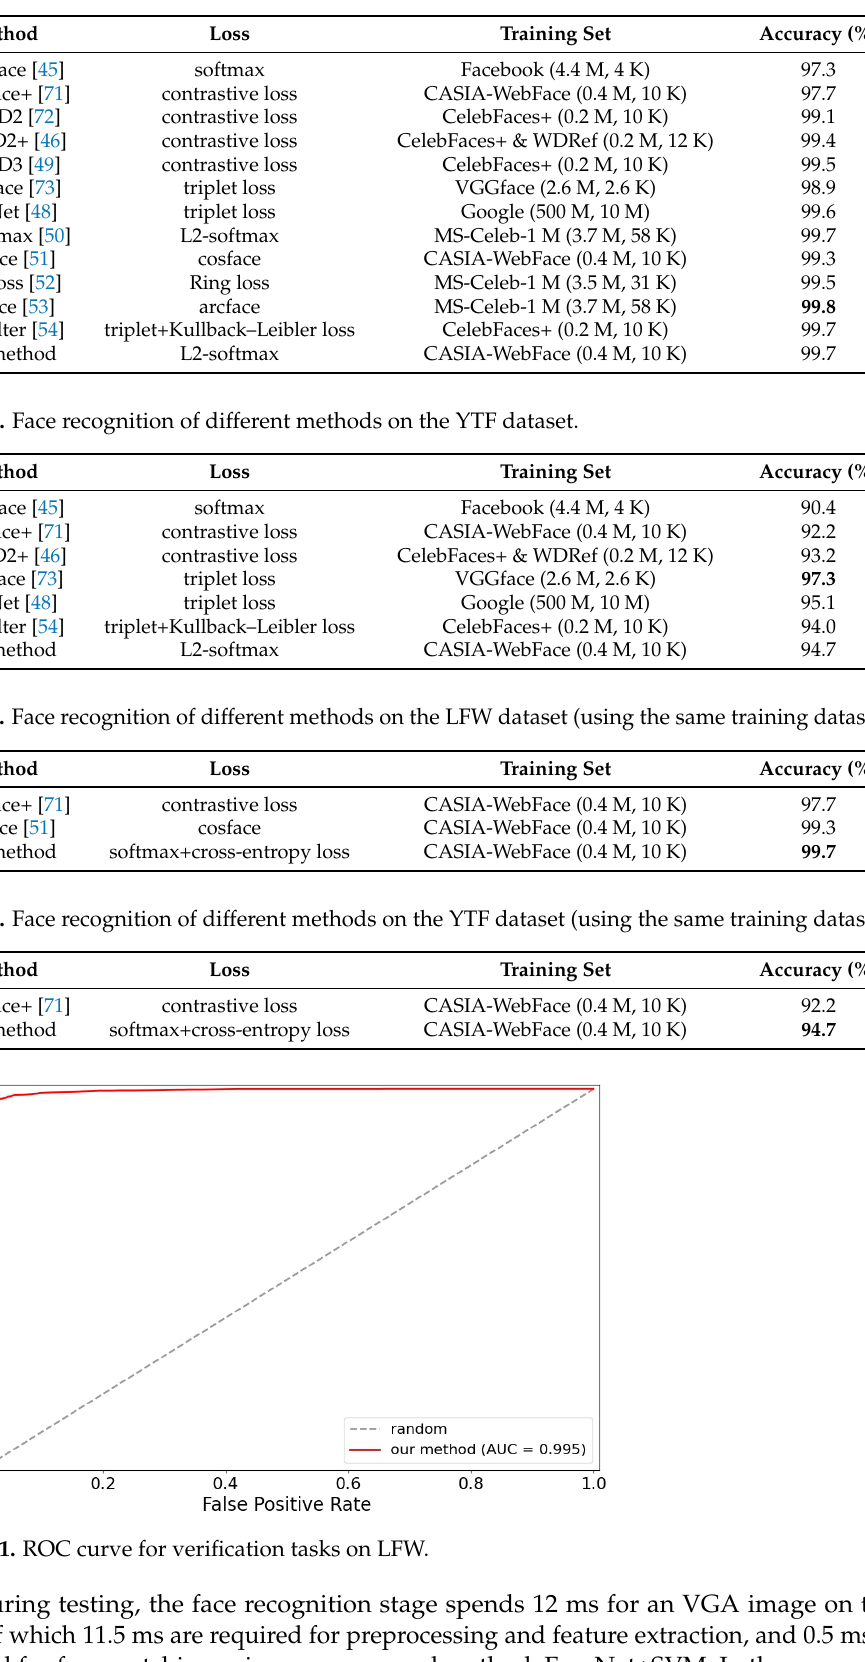
Table 12. Face recognition of different methods on the LFW dataset.